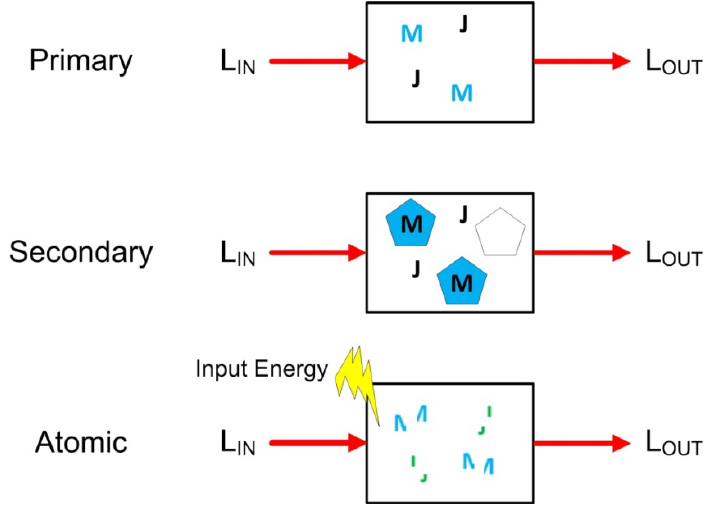
Figure 8. Simplified representation of three forms of considered absorption and atomic absorption techniques. Primary absorption involves direct absorption spectroscopy of the sample. Secondary absorption involves the addition of chromogenic compounds that permit the selective measure of certain ions. Atomic absorption spectroscopy uses different forms of input energy to obtain the atomic form of the contained components that have characteristic optical properties. L = incident light, L = transmitted light, M = analyte IN OUT of interest, J = interfering species, = chromogenic complexing